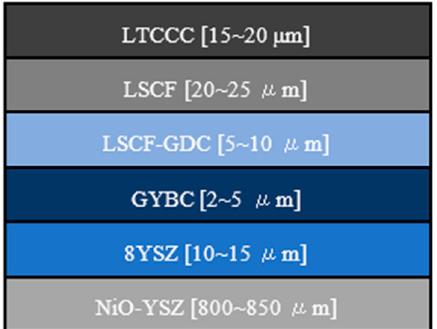
Figure 1. Schematic description of solid oxide fuel cells employed in the application of atomic layer deposition to energy-based